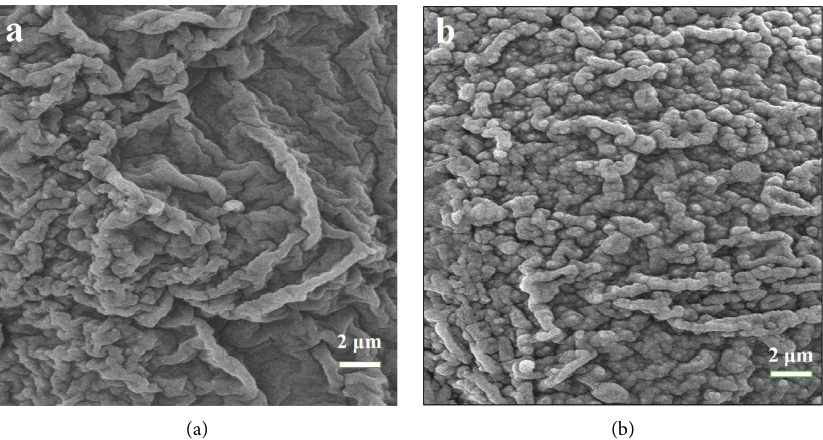
Figure 3: The electron microscope scans under different methods. (a) The untreated sample was heated to 60 ° C. (b) The sample of cooling gradient was heated to 60 ° C.